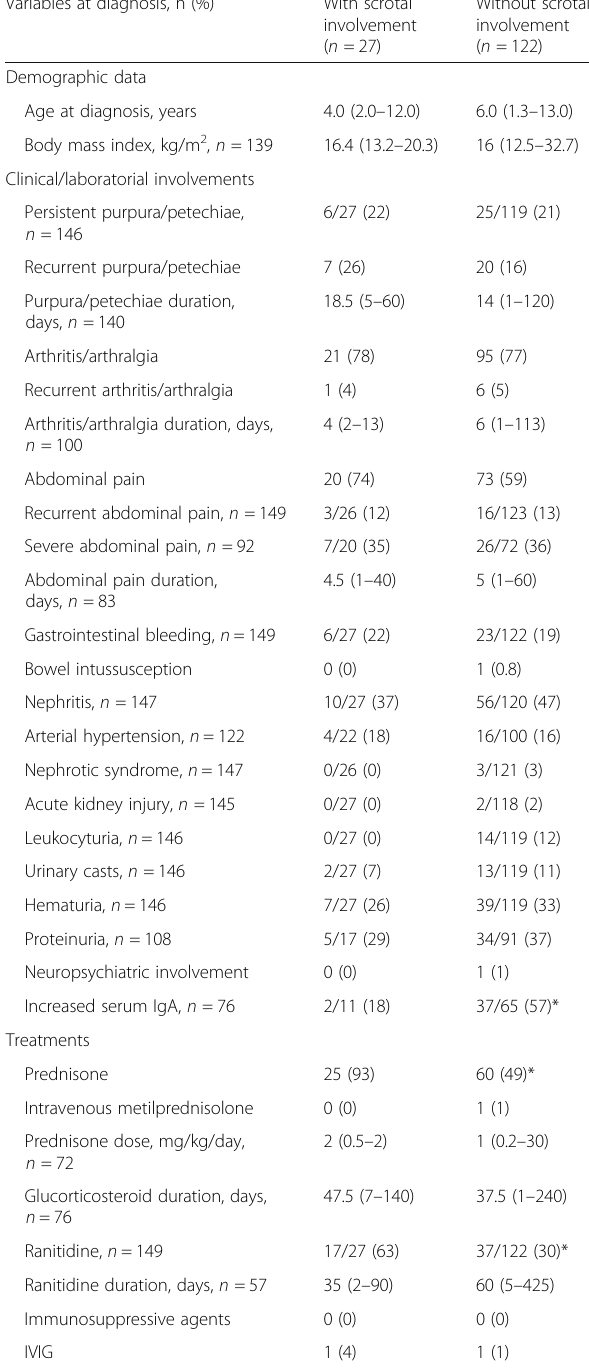
Table 2 Demographic data, clinical manifestations and treatments in patients with scrotal involvement at first episode compared to those without this condition in 149 IgA